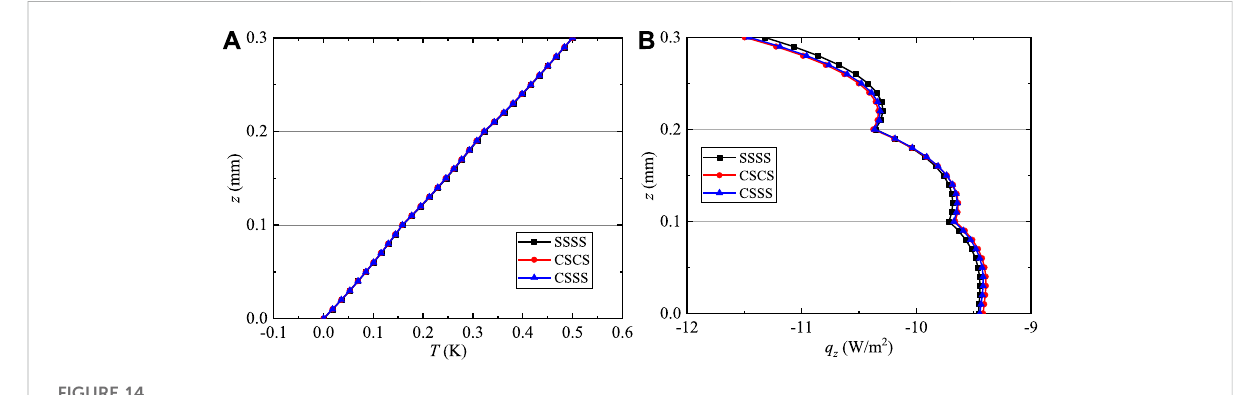
FIGURE 14 Variation of the temperature and heat fl ux for QC coating structures: (A) T and (B) q z